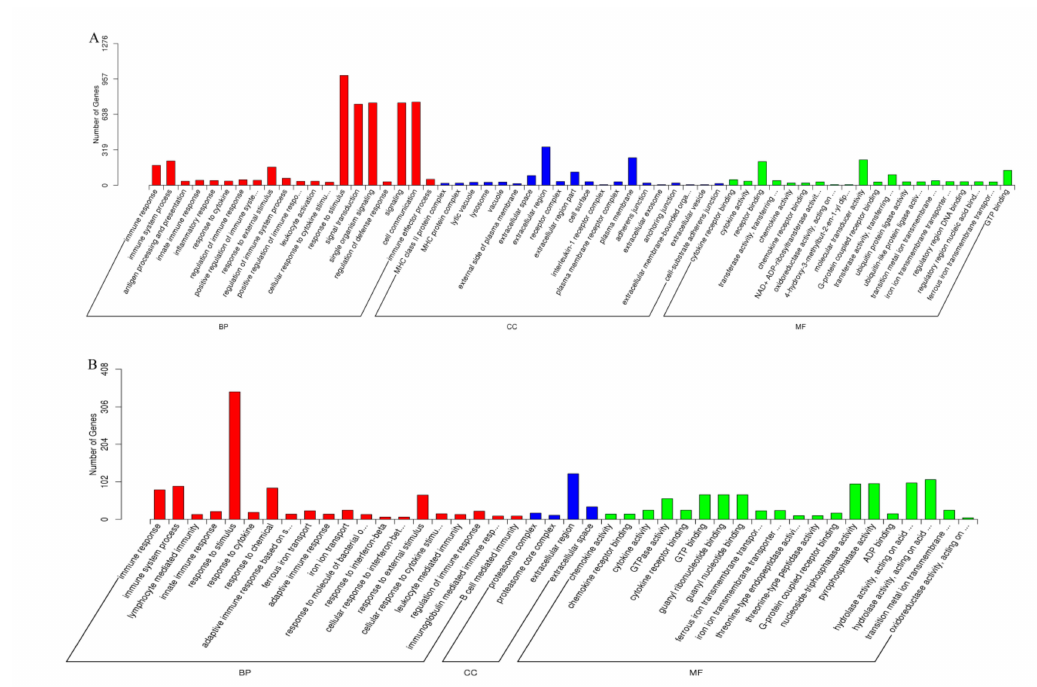
Figure 3. GO enrichment chart for the DEGs in the EV71-treated and CVA16-treated groups. DEGs were classified into three types: Biological process (BP), cellular component (CC), and molecular function (MF). ( A ) EV71-treated group compared to the control group. ( B ) CVA16-treated group compared to the control group.